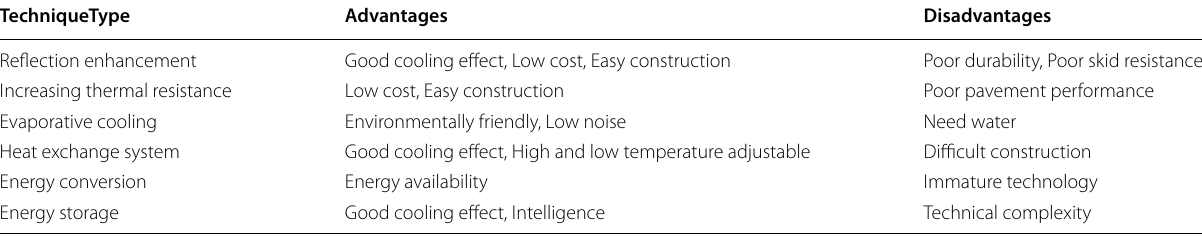
Table 7 Advantages and disadvantages of different regulation techniques